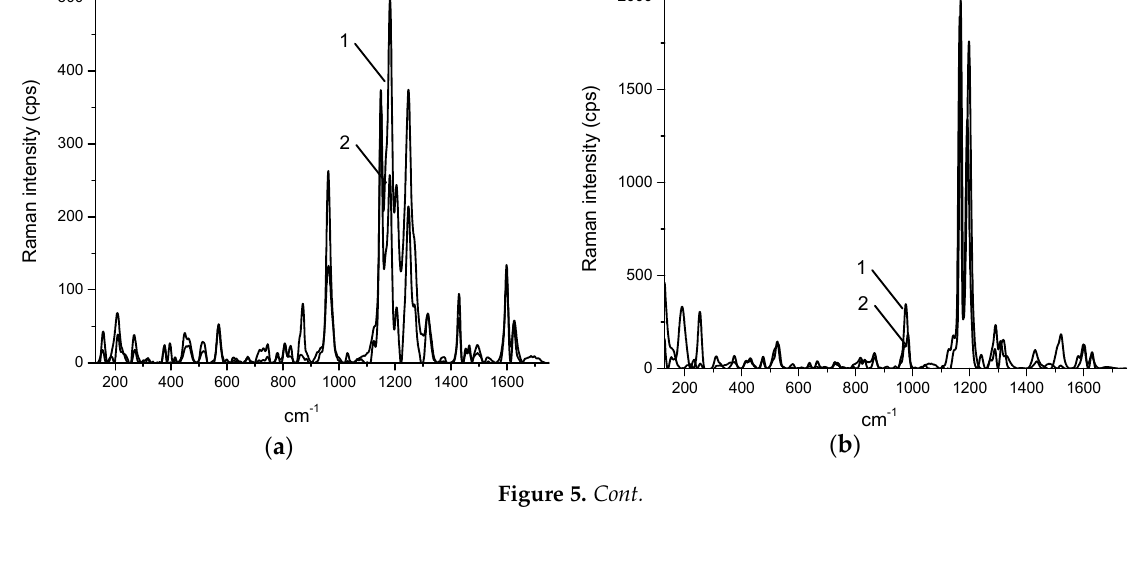
( d ) ( d ) Figure 5. Typical Raman spectra and micrographs of cream (( a ) and ( c ), respectively) and gel (( b ) and ( d ), respectively) containing curcumin before and after the irradiation in the absence of nail, where